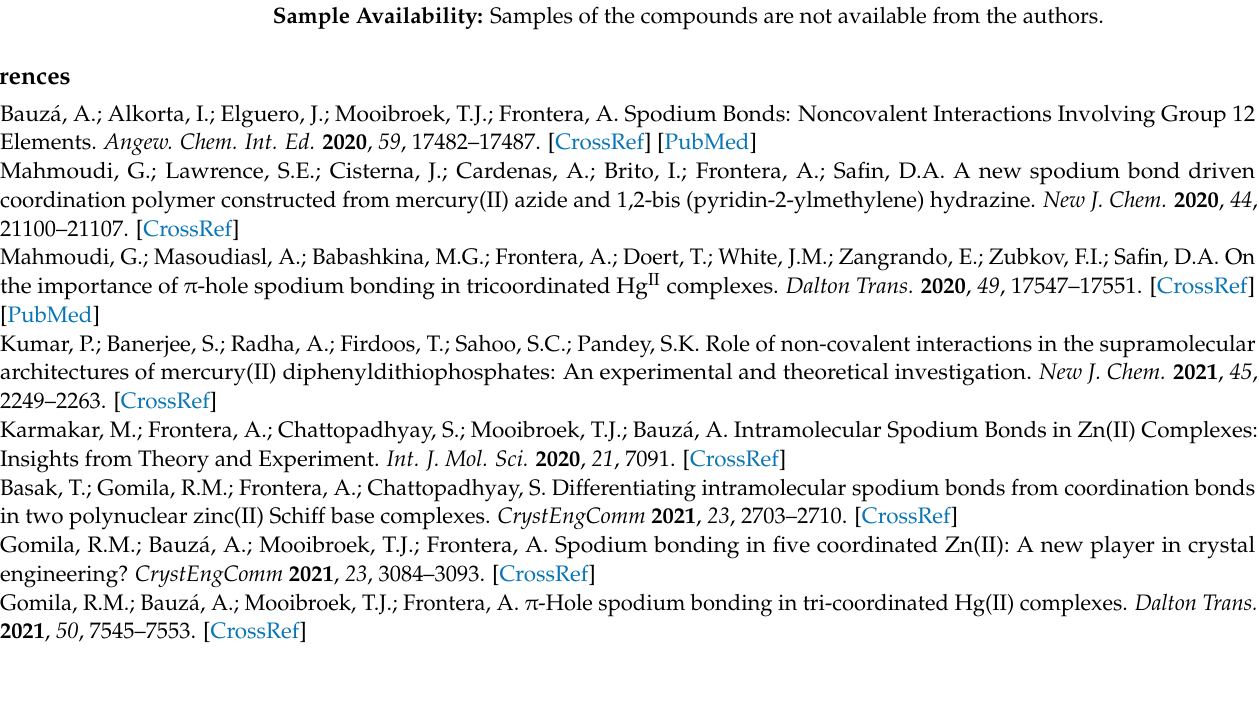
weak repulsive, and strong repulsive interactions, respectively. Figure S3: plots of the reduced density gradient RDG versus the electron density multiplied by the sign of the second Hessian eigenvalue (sign( λ 2 ) ρ ) of MX 2 · · · C 2 H 2 –T. NCI maps of the corresponding binary complexes. Figure S4: plots of the reduced density gradient RDG versus the electron density multiplied by the sign of the second Hessian eigenvalue (sign( λ 2 ) ρ ) of MX 2 · · · C 2 H 4 –P. NCI maps of the corresponding binary complexes. Figure S5: plots of the reduced density gradient RDG versus the electron density multiplied by the sign of the second Hessian eigenvalue (sign( λ 2 ) ρ ) of MX 2 · · · C 2 H 4 –T. NCI maps of the corresponding binary complexes. Figure S6: plots of the reduced density gradient RDG versus the electron density multiplied by the sign of the second Hessian eigenvalue (sign( λ 2 ) ρ ) of MX 2 · · · C 2 F 2 –T. NCI maps of the corresponding binary complexes. Figure S7: Pplots of the reduced density gradient RDG versus the electron density multiplied by the sign of the second Hessian eigenvalue (sign( λ 2 ) ρ ) of MX 2 · · · C 2 Li 2 –T. NCI maps of the corresponding binary complexes.Figure S8: molecular graphs of spodium– π bonded stable complexes at the intermolecular bond critical points. Figure S9: electron density shifts of the MX 2 · · · C 2 H 2 –P complexes (iso = ± 0.0008). Red regions indicate increased electron density, while blue regions represent decreased electron density. Figure S10: electron density shifts of the MX 2 · · · C 2 H 2 –T complexes. Figure S11: electron density shifts of the MX 2 · · · C 2 H 4 –P complexes. Figure S12: Electron density shifts of the MX 2 · · · C 2 H 4 -T complexes. Figure S13: electron density shifts of the MX 2 · · · C 2 F 2 –P complexes. Figure S14: electron density shifts of the MX 2 · · · C 2 Li 2 –P complexes. Figure S15: comparison of electrostatic, polarization, and dispersion energies in the binary